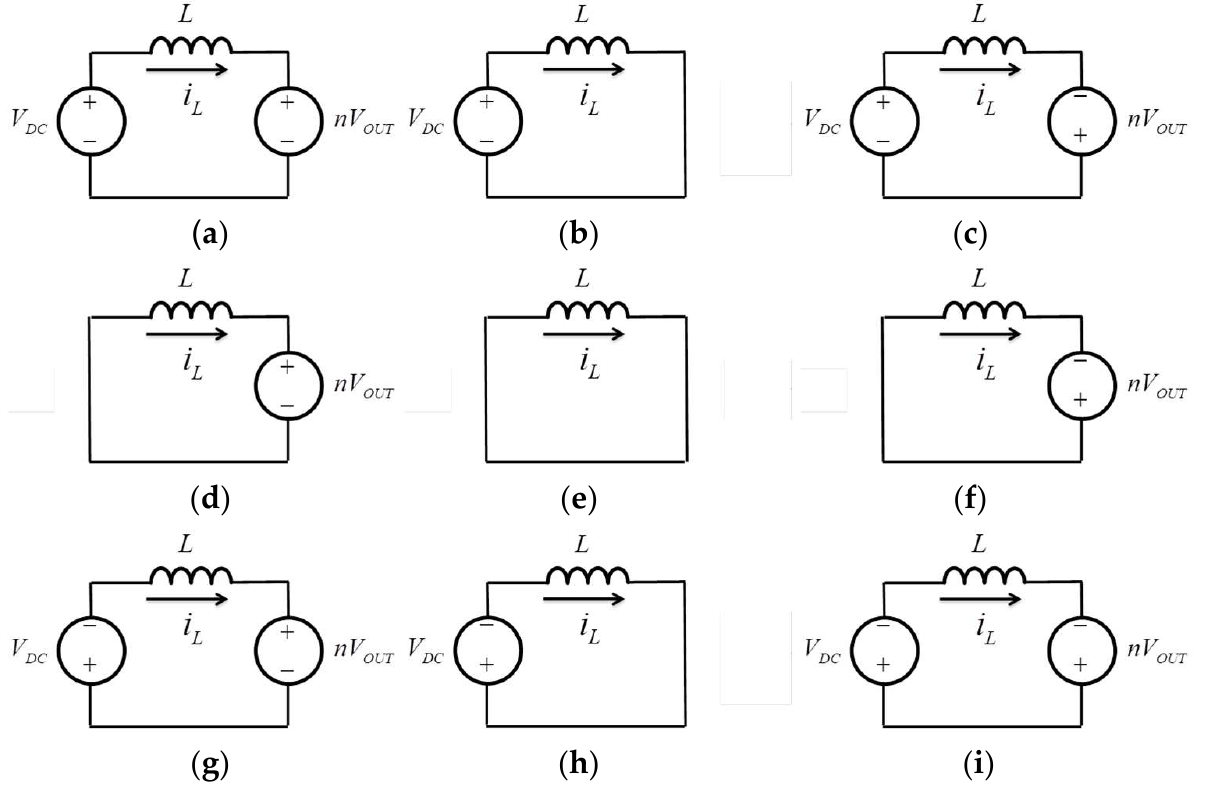
Figure 3. Traditional single-phase-shift (SPS) modulation main waveforms.